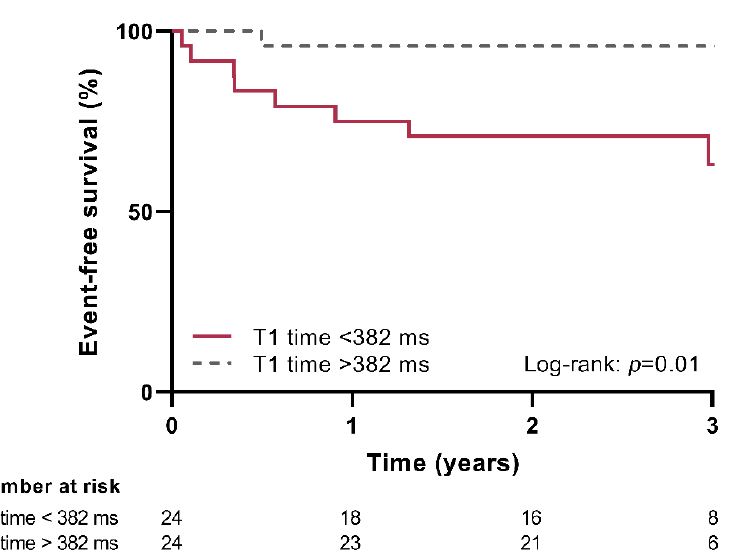
Figure 4. Kaplan-Meier survival curve for the primary combined endpoint (i.e., HF hospitalization and all-cause mortality) in LGE-positive patients, stratified by median post-contrast T1 time of the non-infarcted myocardium.